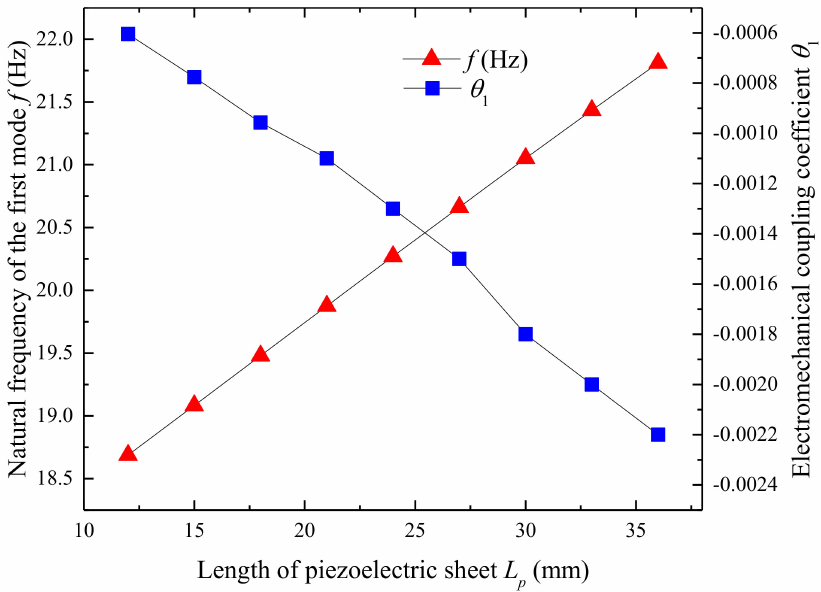
Figure 11. Variation of the first natural frequency and electromechanical coupling coefficient as a function of the length of piezoelectric sheet.